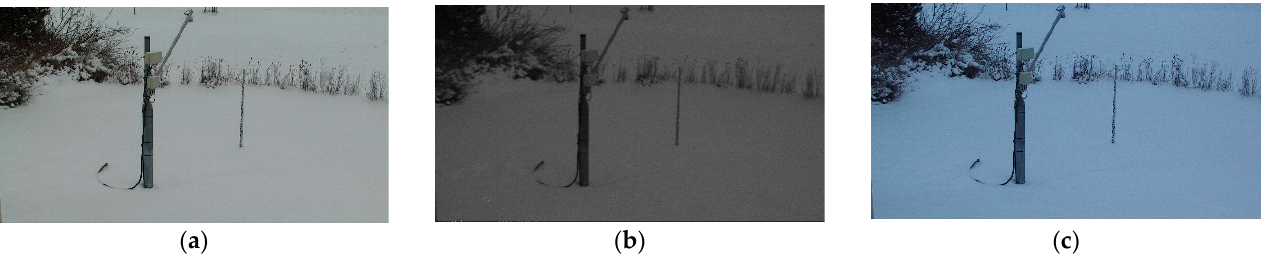
Figure 3. Example images from Jokioinen camera for filtering by brightness and blue fraction: ( a ) nominal; ( b ) low brightness; ( c ) high blue fraction.